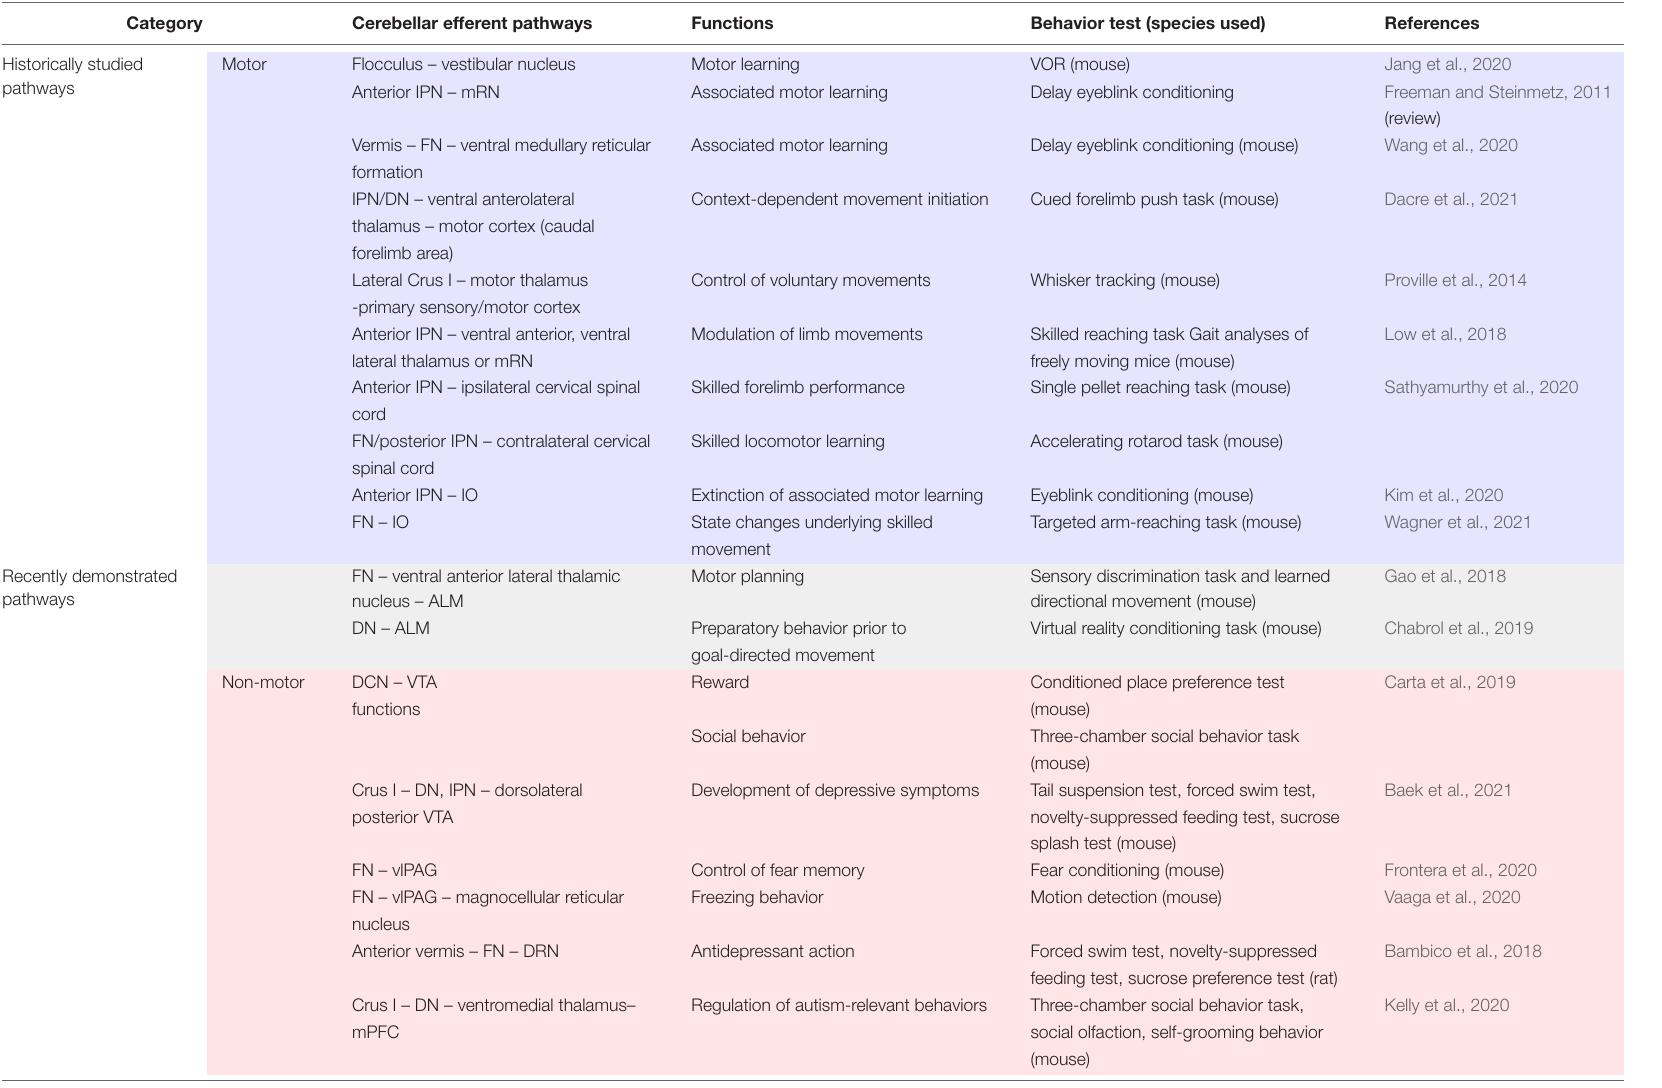
TABLE 1 | Behavioral analyses demonstrating non-primary motor functions of cerebellar efferent pathways that have been recently demonstrated (gray and